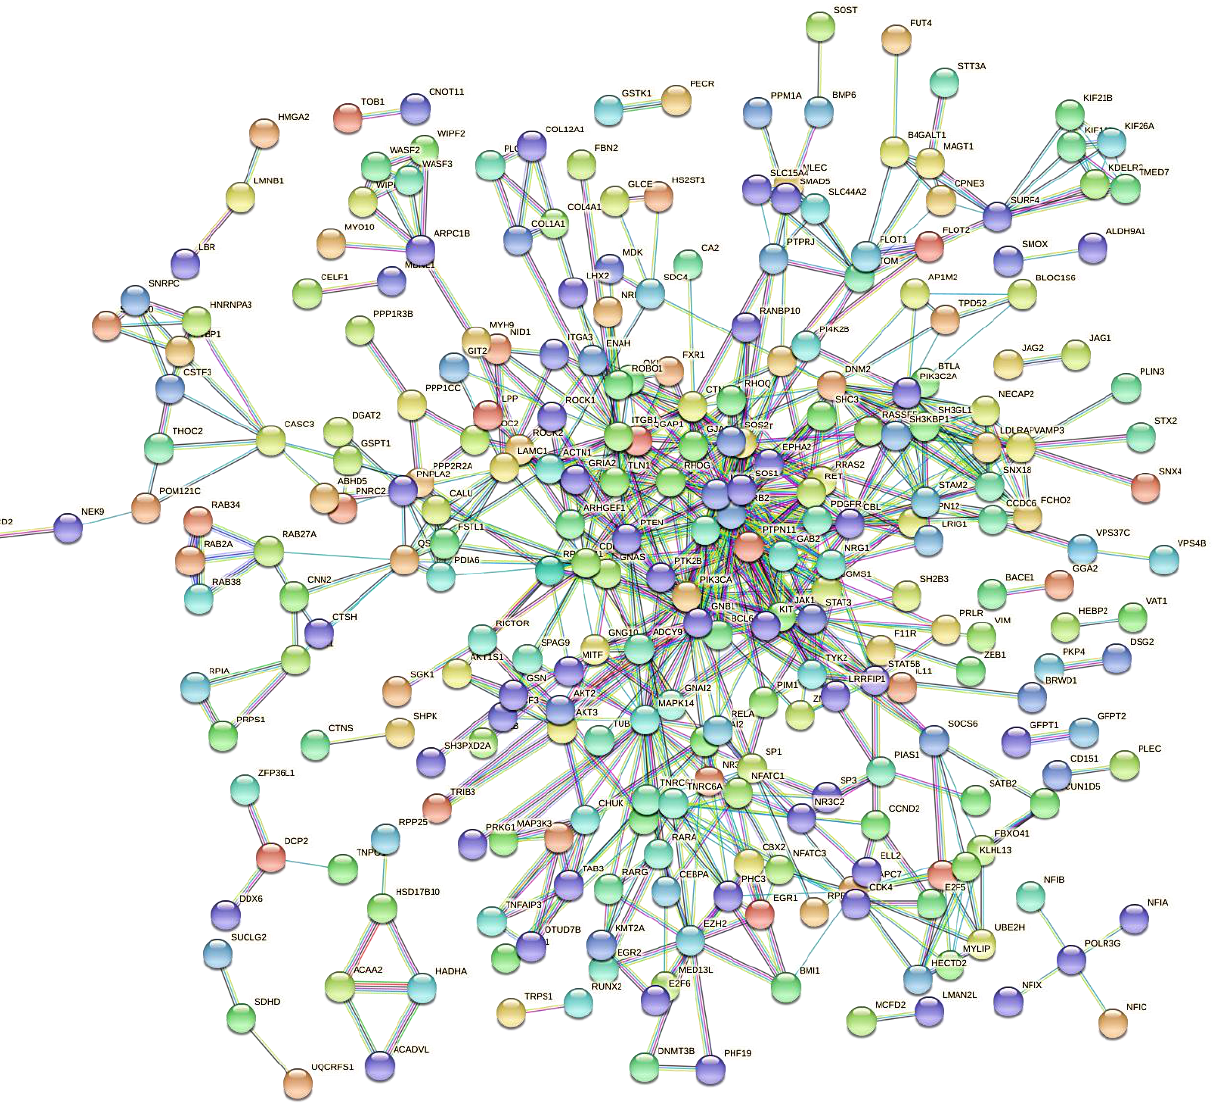
Figure 3. Protein–protein interaction network. The model shows that a total of 271 proteins encoded by the target mRNAs of miR-23b-3p, miR-124-3p, or miR-218-5p could interact to regulate cellular processes. The nodes represent the proteins, and the lines depict the interactions between them.